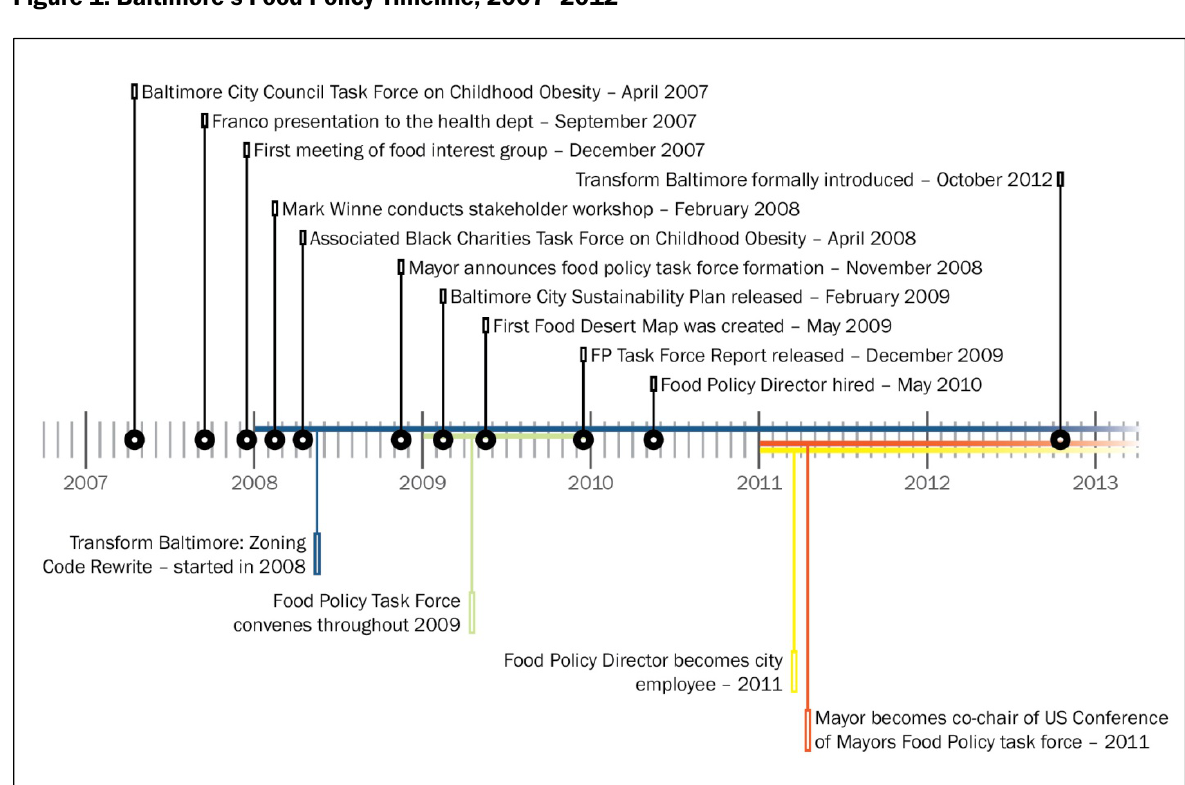
Figure 1. Baltimore’s Food Policy Timeline,